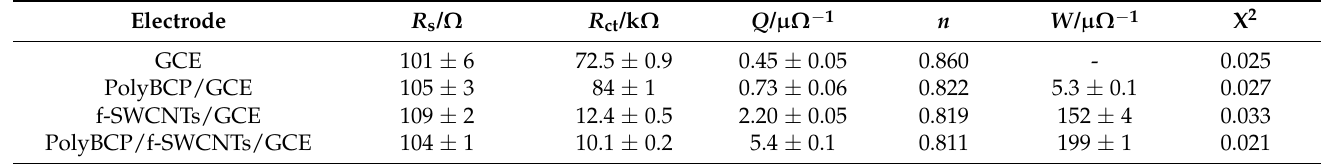
Table 1. Electrochemical impedance parameters of the electrodes ( n = 5; p =